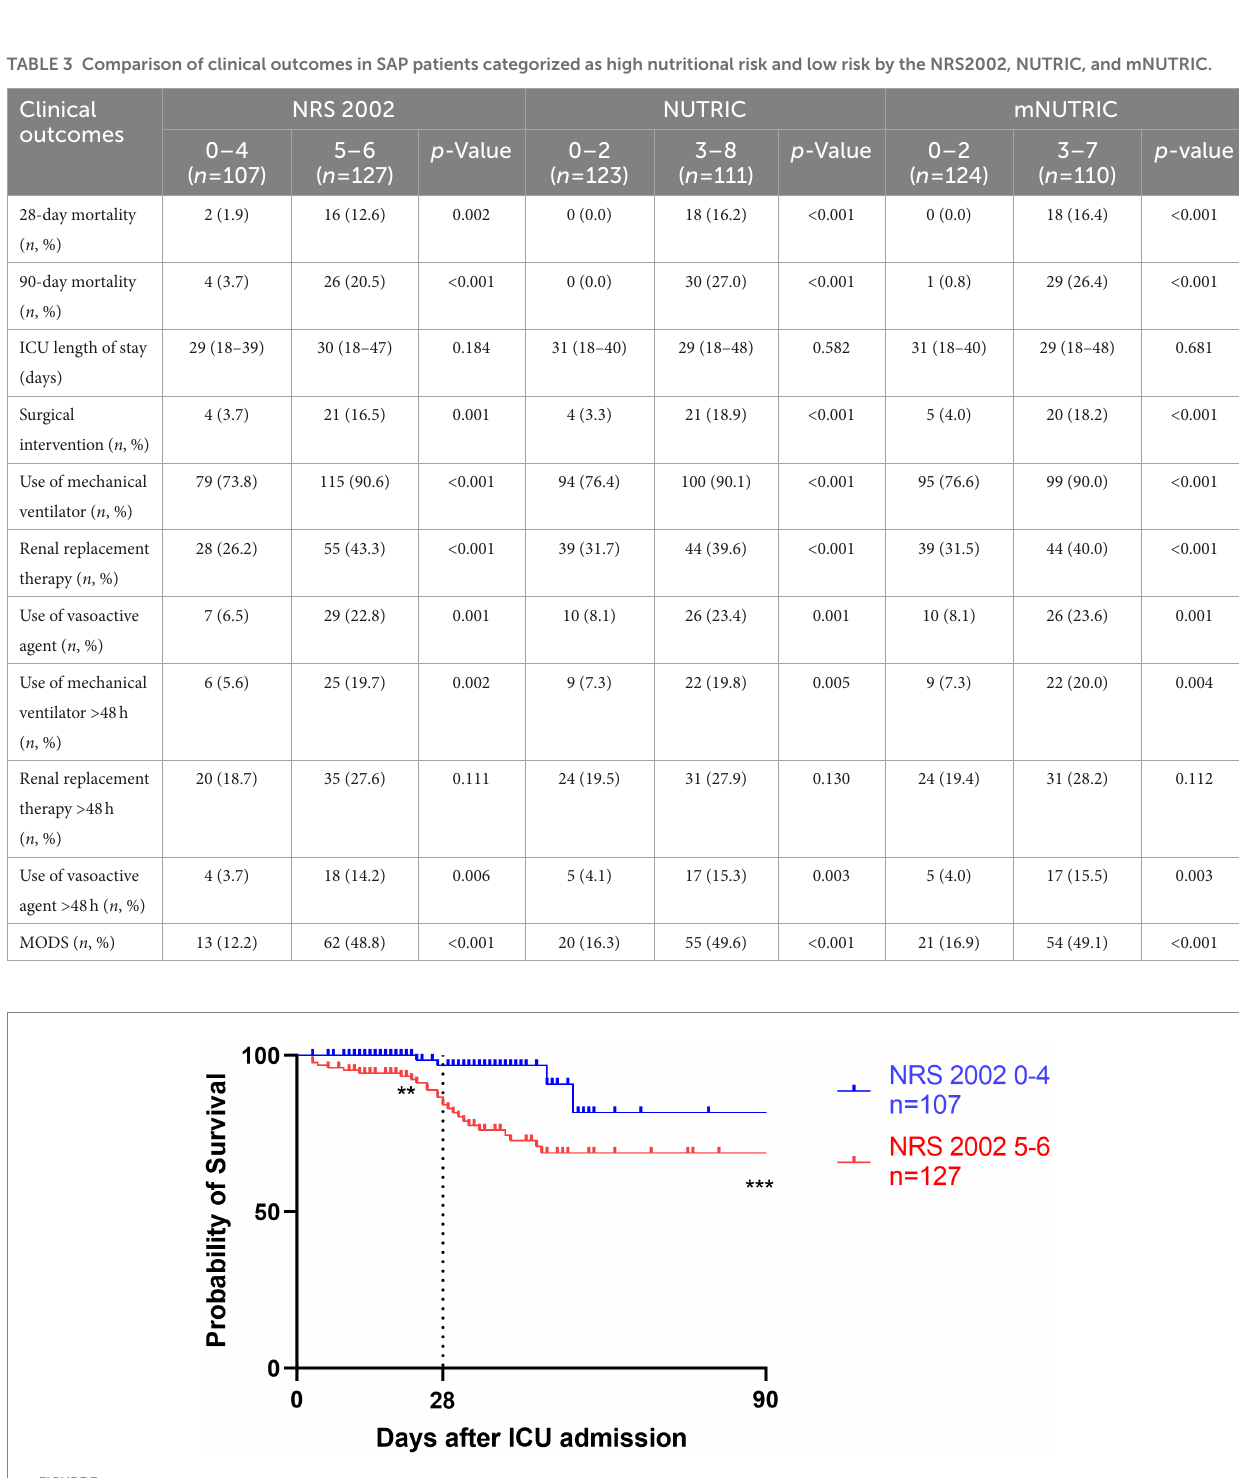
FIGURE 3 Kaplan–Meier survival analyses depending on baseline scores of low NRS 2002 0-4 (blue line, n = 107) versus high NRS 2002 5-6 (red line, n = 127); ** p < 0.05, *** p <